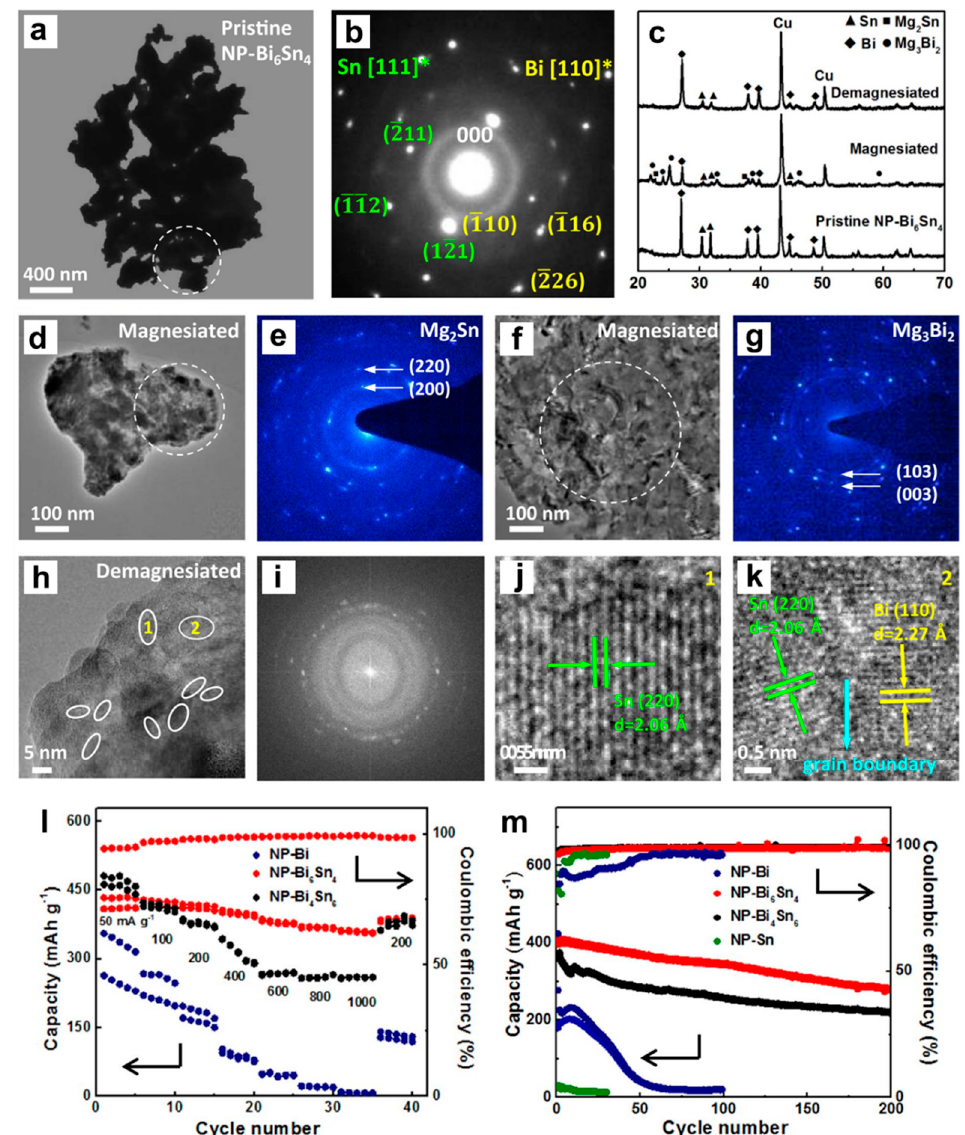
Figure 11. ( a ) TEM image and ( b ) the corresponding SAED pattern of pristine nanoporous Bi 6 Sn 4 alloy. ( c ) Ex situ XRD patterns of the Bi 6 Sn 4 electrode before and after the first discharge/charge. ( d , f ) TEM images and ( e , g ) the corresponding SAED patterns of the first magnesiated Bi 6 Sn 4 electrode. The areas for electron diffraction are marked by white circles in ( a , d , f ). ( h ) HRTEM image of the first demagnesiated Bi 6 Sn 4 electrode, ( i ) the corresponding FFT pattern and ( j , k ) the enlarged HRTEM images corresponding to regions 1 and 2 in ( h ). ( l ) Rate performance and ( m ) cycling stability of the nanoporous Bi, Bi-Sn and Sn electrodes. Reproduced with permission [47]. Copyright 2018, Elsevier B.V.